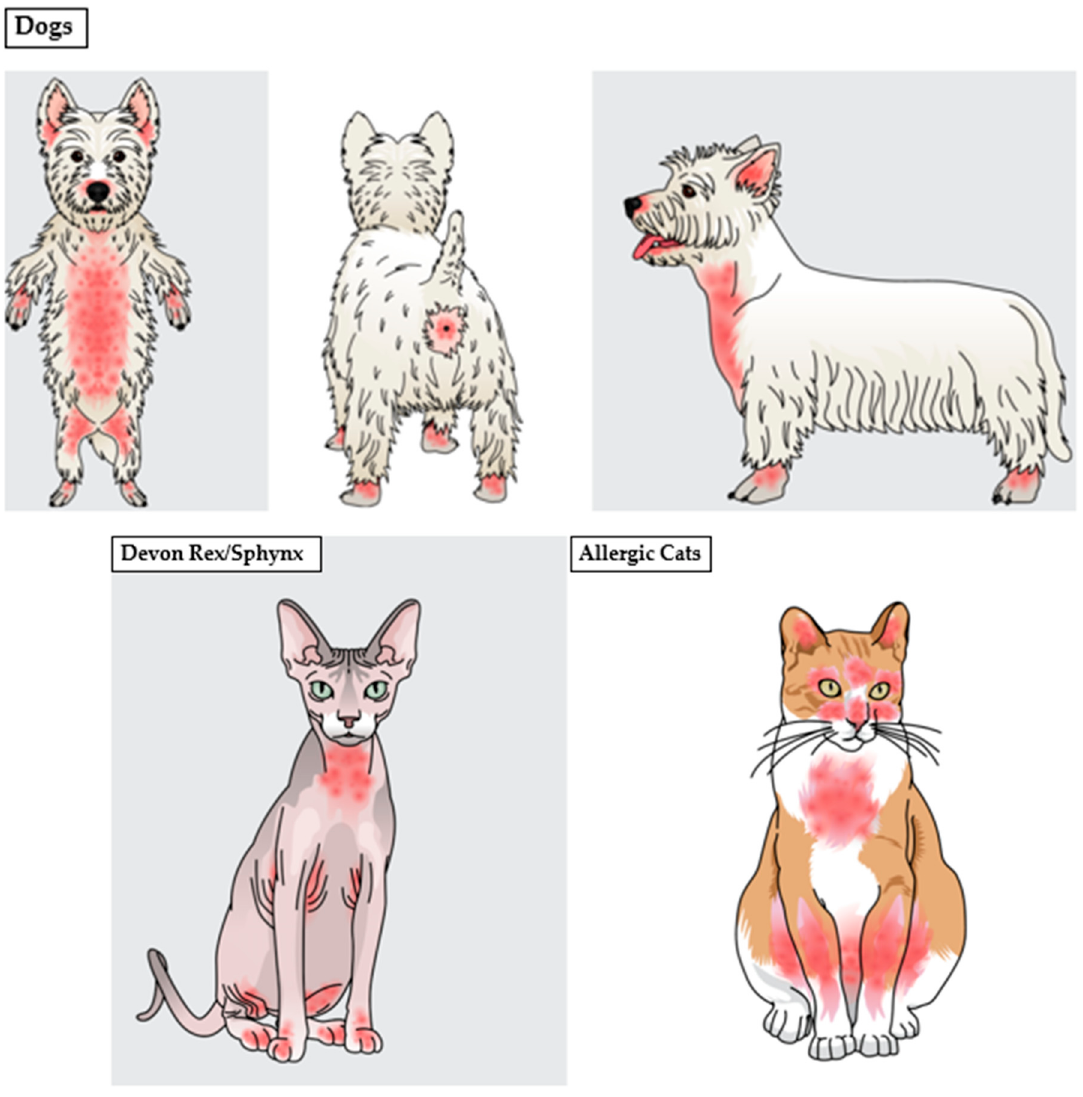
Figure 4. Common affected skin sites in dogs and cats with Malassezia -associated dermatitis and otitis externa. In cats, generalized diseases can also be seen.